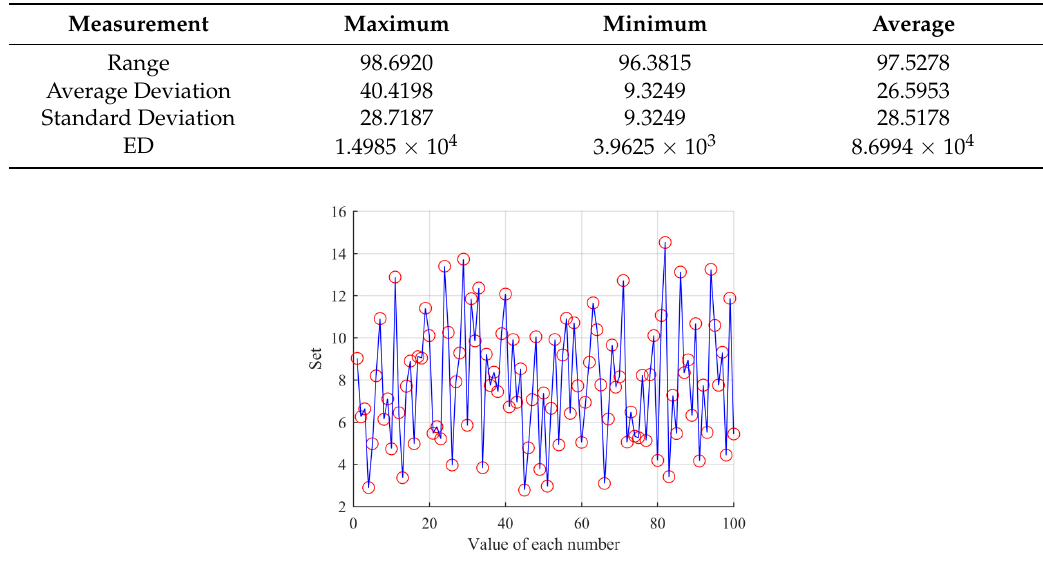
Figure 4. Distribution of values.